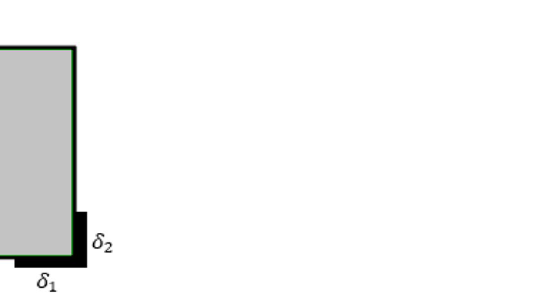
Figure 1. First boundary value problem.